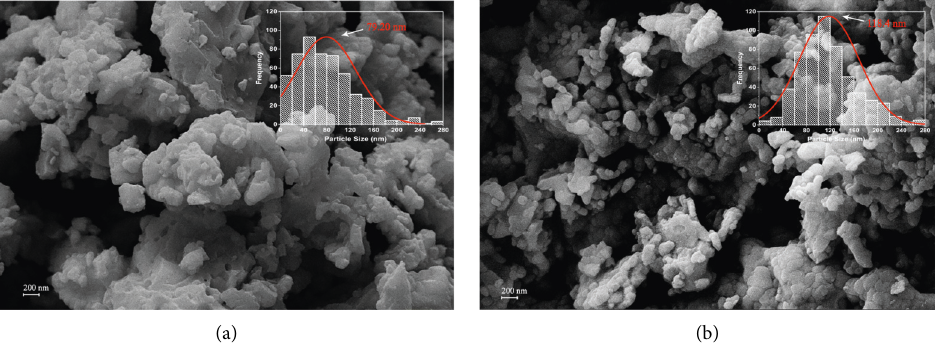
Figure 9: FESEM images and particle size distribution of Ni